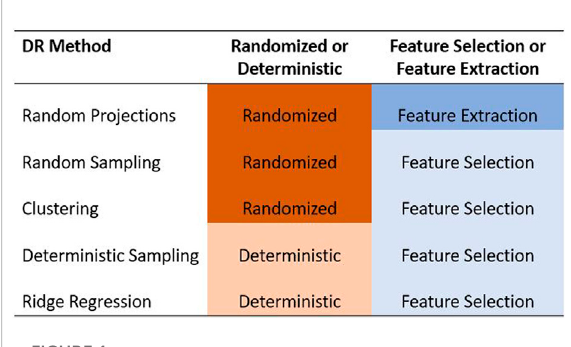
FIGURE 1 Summary of the fi ve dimensionality reduction methods